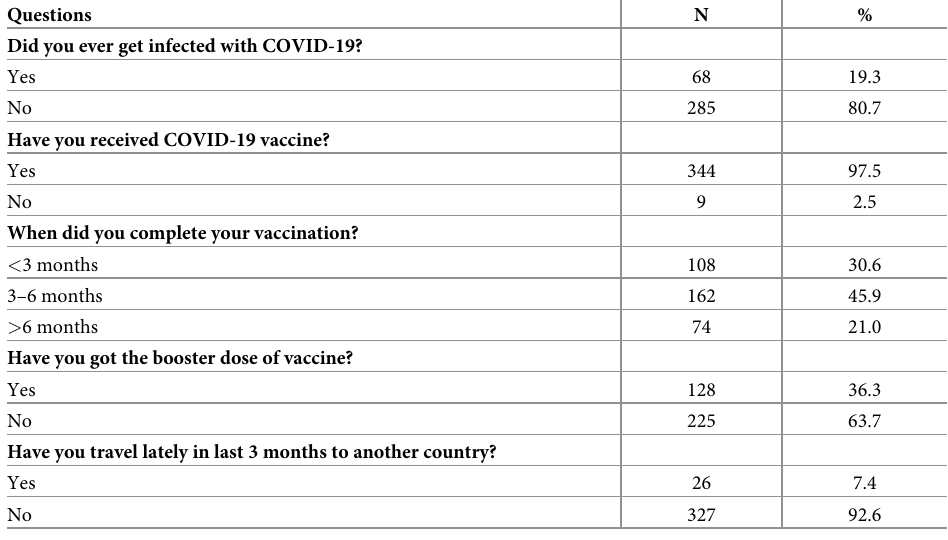
Table 2. Respondents history related to COVID-19 infection, vaccination and travelling.